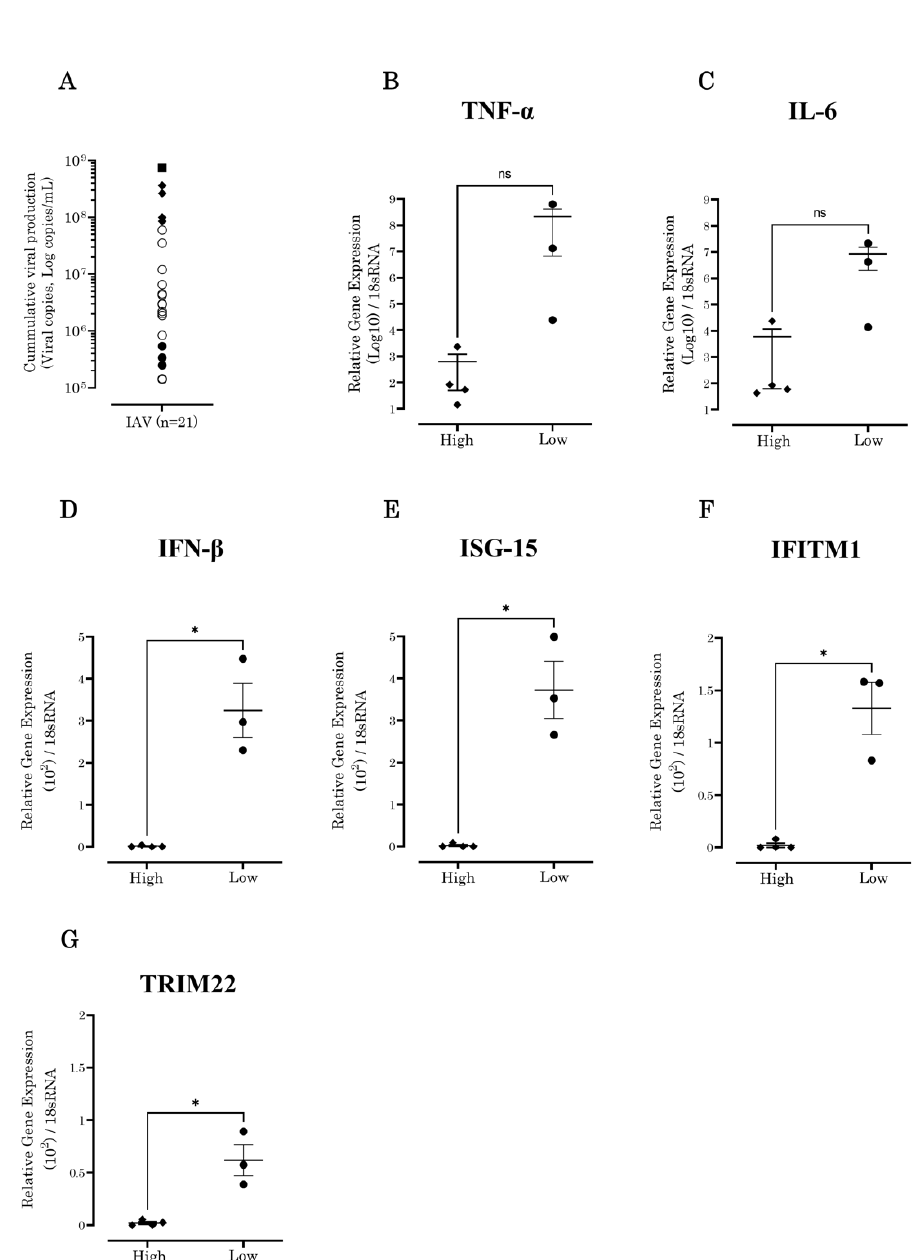
Figure 1. IFN- β and ISG expression levels were different in IAVs with high and low growth capa- bilities. ( A ) The distribution of growth capabilities is shown for 21 clinical samples in vitro using A549 cells at 7 days post-infection. The viral growth capabilities of the highest ( n = 4) and lowest ( n = 3) viral copy seasonal IAV strains were selected for gene expression evaluation at 6 h. Laboratory strain IAV PR8 ( ) was used as positive control. ( B ) TNF- α and ( C ) IL-6 showed no significant differences when compared between high and low growth capabilities. However, ( D ) IFN- β ( p = 0.0.0170), ( E ) ISG-15 ( p = 0.0.0378), ( F ) IFITM1 ( p = 0.0.0004), and ( G ) TRIM22 ( p = 0.0.0020) were significantly different.